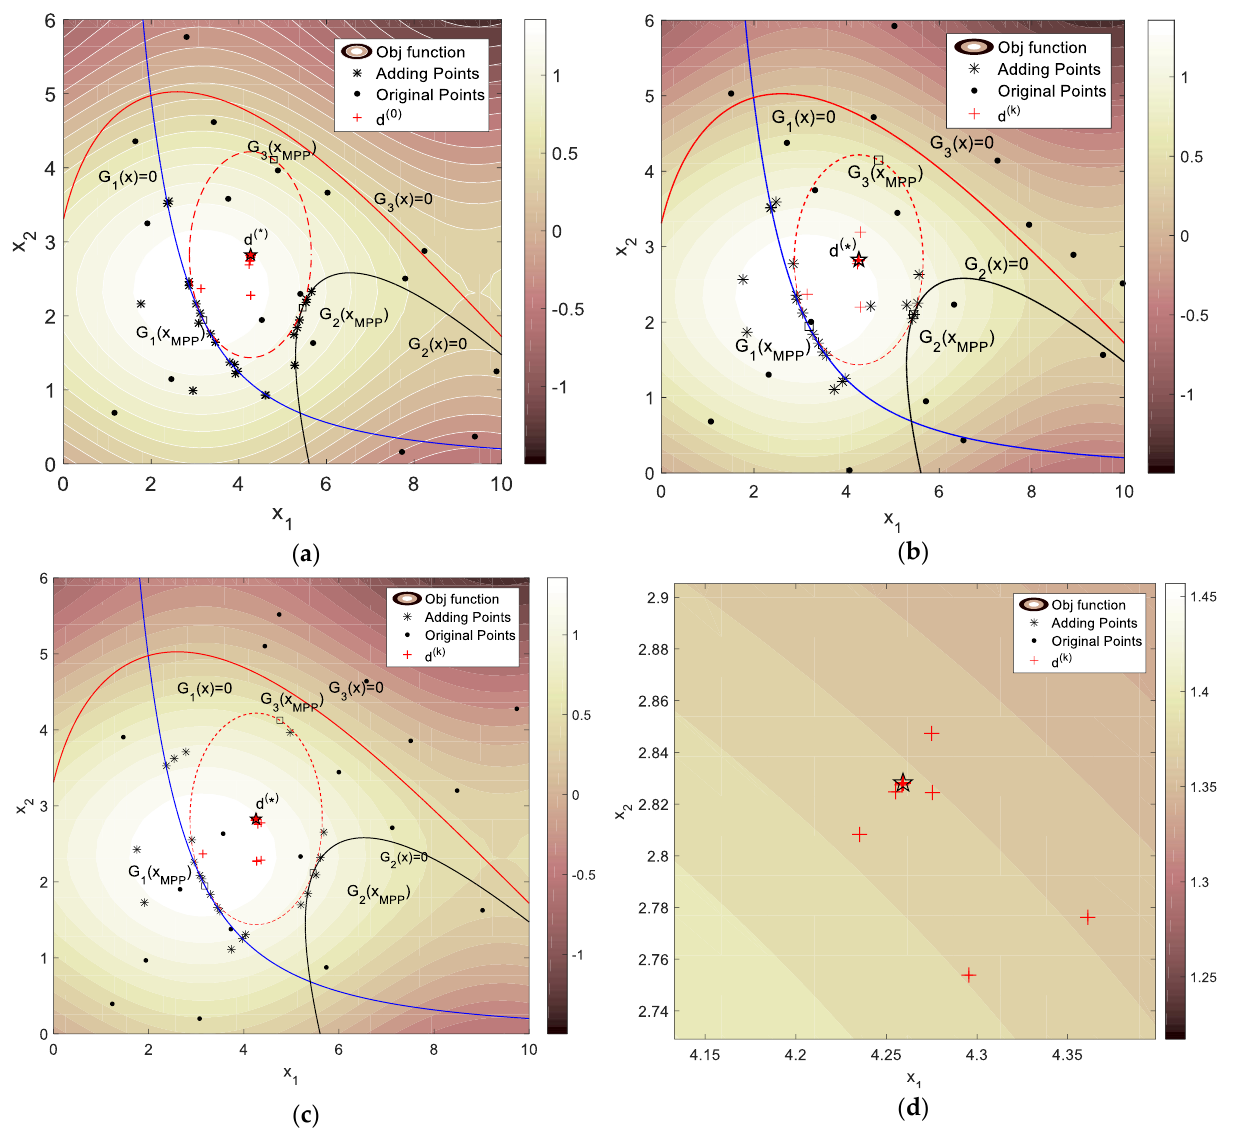
Figure 5. The searching history figures of multi-mode case by SORA. ( a ) No AIC d s = 0.5; ( b ) PAIC d s = 0.5; ( c ) PAIC d s = 1.2; ( d ) Zoom on (PAIC d s = 1.2). The five-pointed star denotes the real optimum.